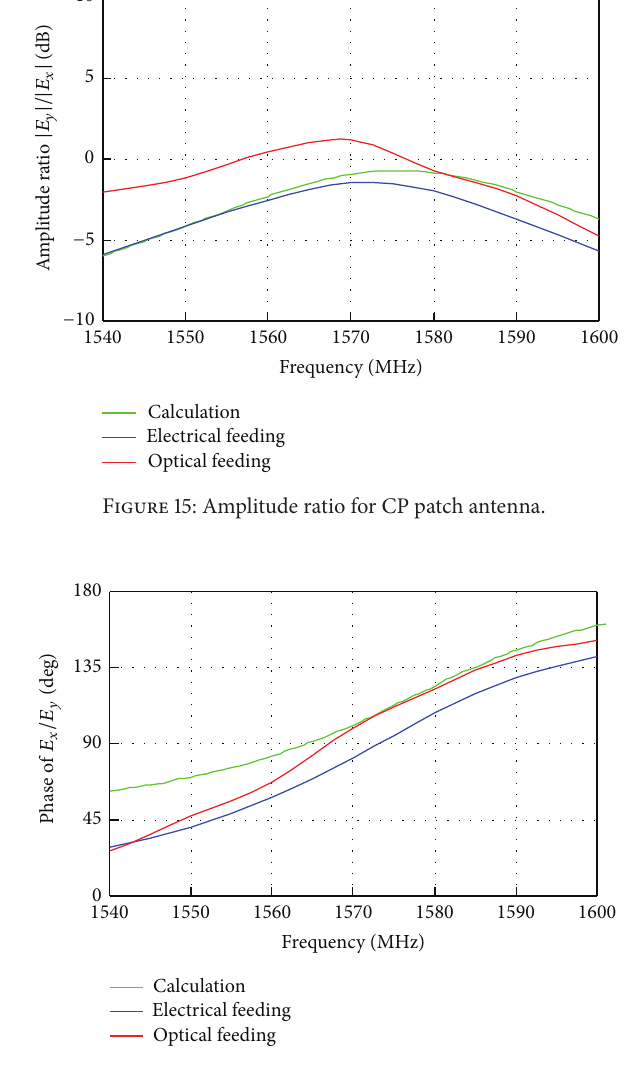
Figure 16: Phase difference for CP patch